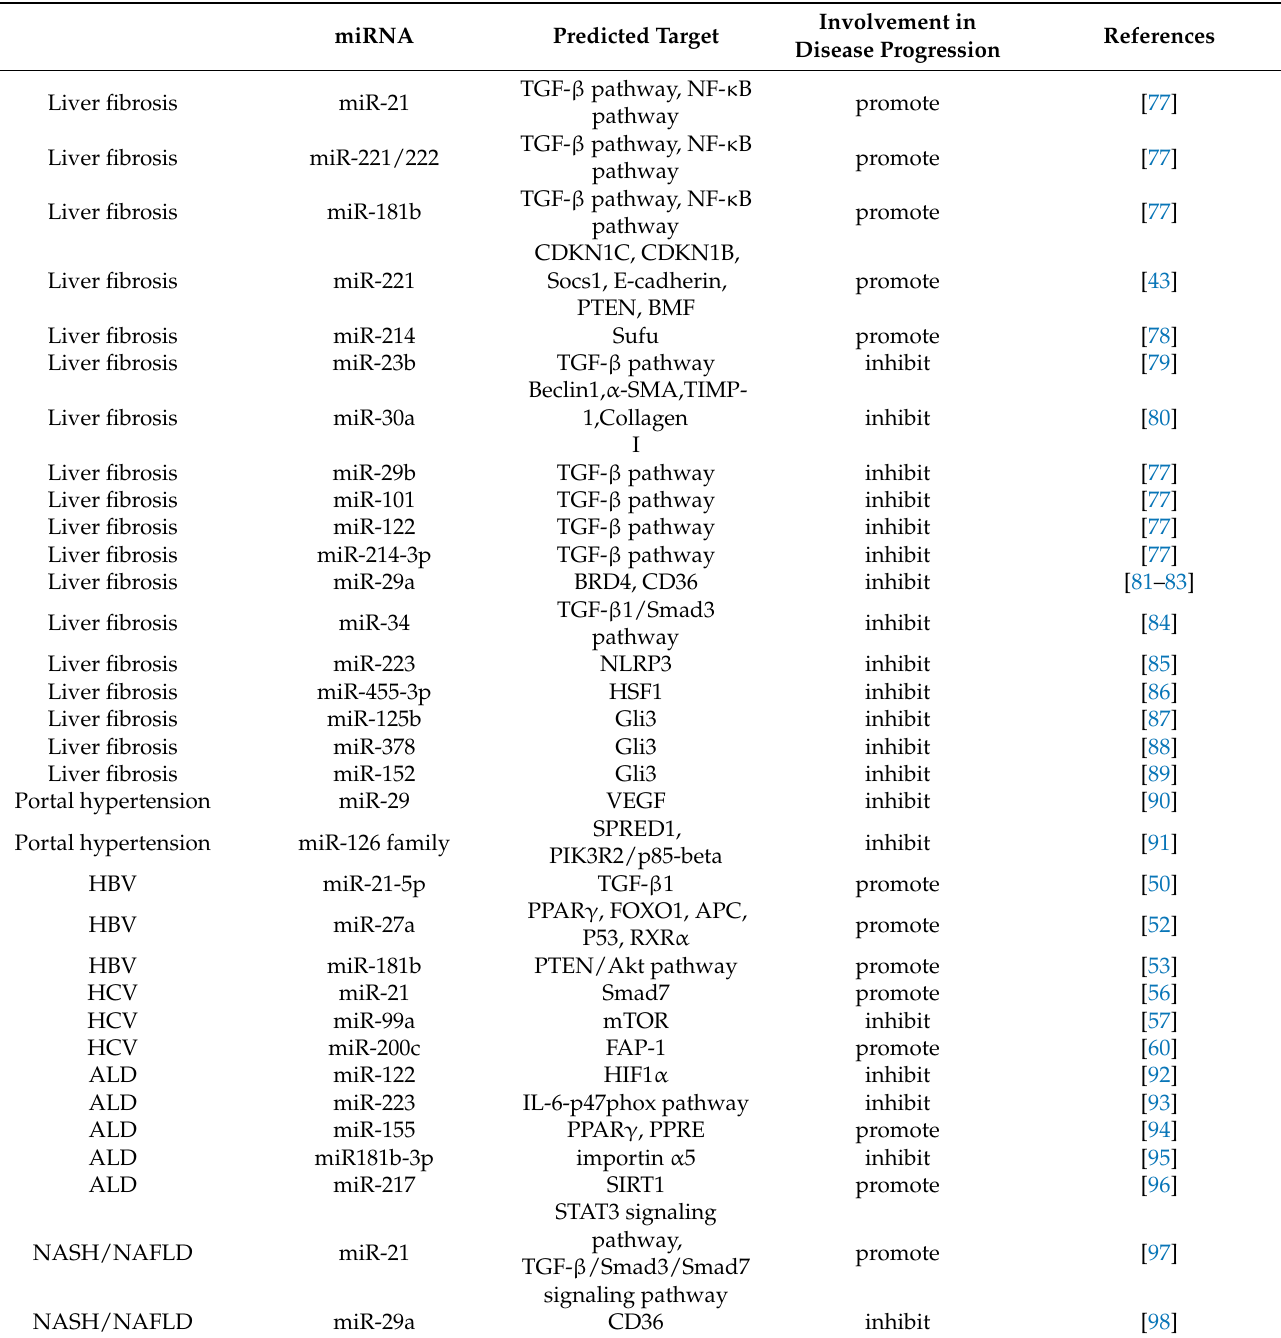
Table 2. Fibrosis-associated